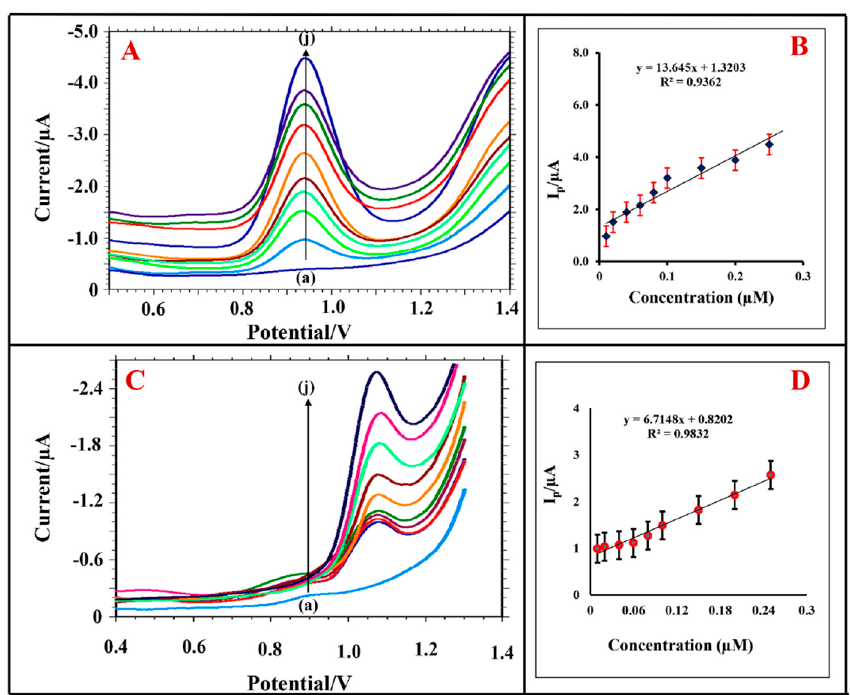
Figure 7. SW-voltammograms measured using g-C 3 N 4 -CTAB-modified CPE of ( A ) Amino-triazole and ( C ) Linuron herbicides. In ( B , D ), corresponding linear concentration ranges for both analytes are shown. Reprinted with permission from Ref. [122] . Copyright 2021 Elsevier Inc.